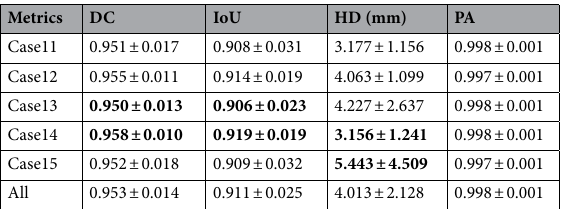
Table 6. Segmentation results of different cases. Bold values indicates maximum and minimum values of the corresponding column or row.